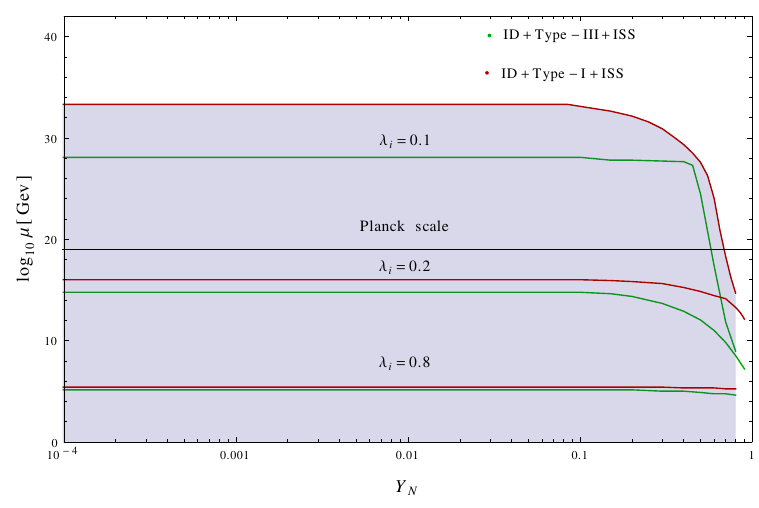
Figure 4 . Bounds from perturbativity scale on Y N as a function of (cid:22) for di(cid:11)erent values of (cid:21) i with y t = 0 : 9369, M N = 100 GeV. The red curve and the green curve corresponds to the ID plus Type- I ISS scenario and ID plus Type-III ISS scenario respectively with two generations of fermionic